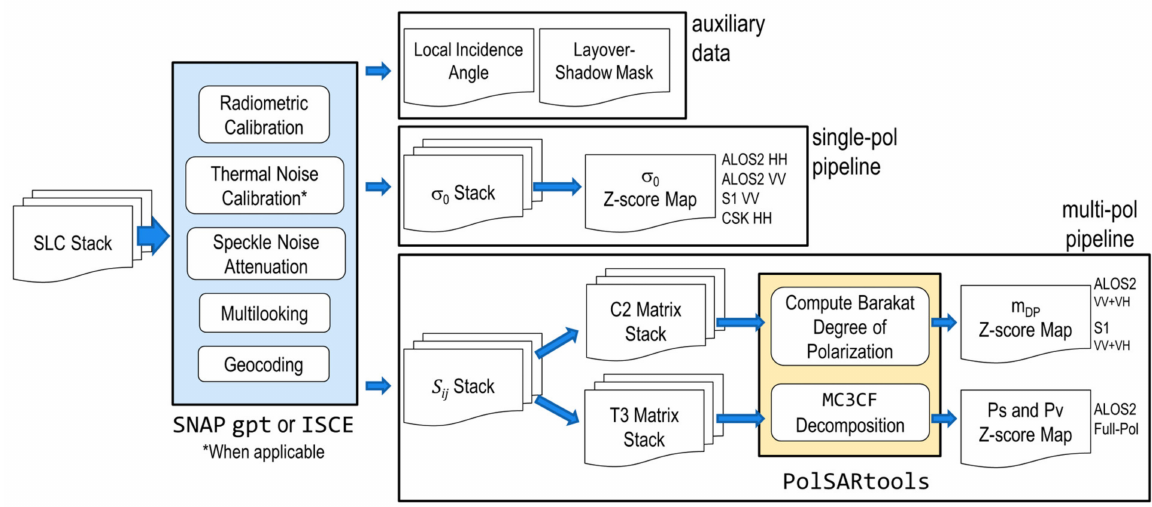
Figure 1. Processing flows for different SAR datatypes used in this